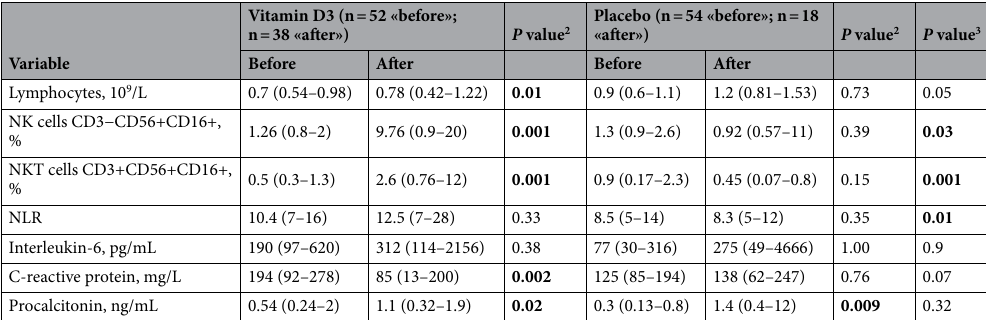
Table 2. Dynamics of lymphocyte counts and inflammatory markers in the vitamin D3 and placebo groups before the treatment and on day 7 after the treatment 1 . 1 Numerical data are expressed as median (IQR); categorical data are shown as the number of cases (percentage). 2 P values were calculated by Wilcoxon test, χ 2 test, or Fisher’s exact test, as appropriate. 3 P values were calculated by Mann–Whitney test between vitamin D3 and placebo groups on day 7. NLR neutrophil to lymphocyte ratio. Significant values are in bold.